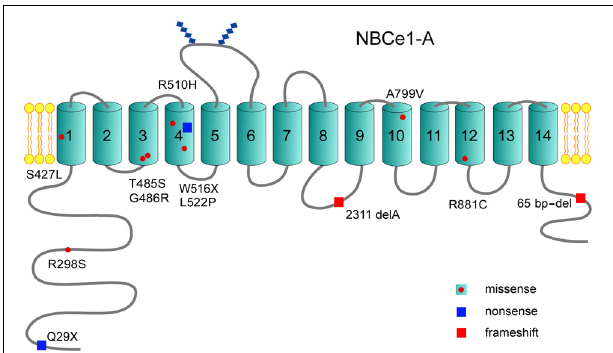
FIGURE 2 | Structural topology of NBCe1-A: The NBCe1-A variant has been the most thoroughly studied and is depicted. Thus far, 12 NBCe1 mutations have been reported that include 8 missense mutations, 2 nonsense mutations, and 2 frameshift mutations. Of the reported missense mutations, the majority are localized to the transmembrane region. All NBCe1 variants share the identical transmembrane region where ion transport is mediated, and have a large cytoplasmic N-terminal region with a shorter cytoplasmic C-terminal